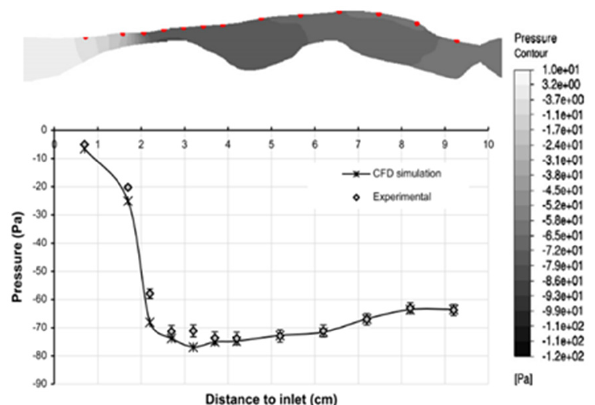
Figure 10. 1:1 scale of the UA model pressure distribution comparison between CFD and the ex- perimental results. Reprinted with permission from Ref. [43] 2013, Moyin Zhao et al.